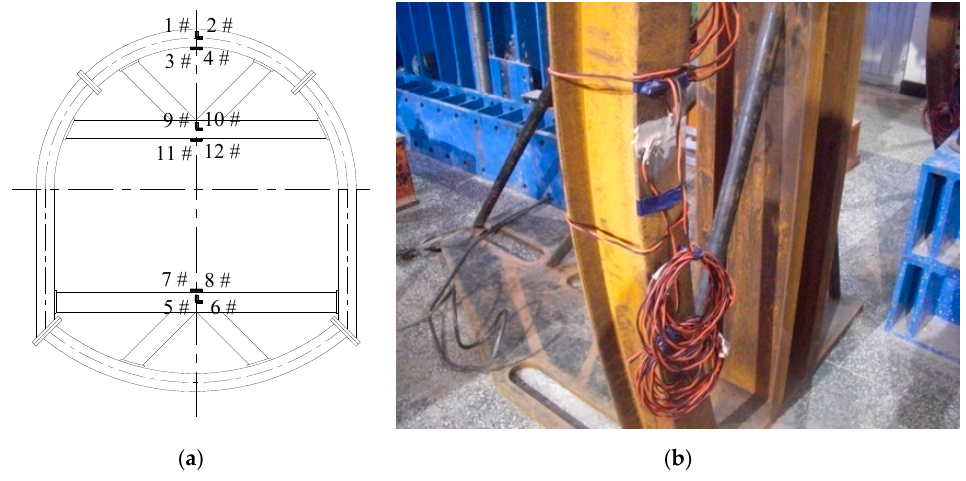
Figure 8. Layout and numbers of strain gauges: ( a ) layout schematic; ( b ) strain gauges in scaled set.